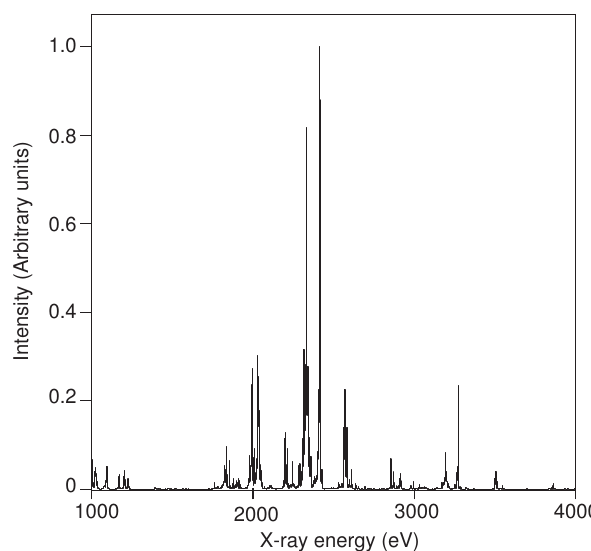
Figure 4. Spectral emission of vanadium-like W 51+ in the 1000 to 4000 eV X-ray range predicted by calculations performed with the Flexible Atomic Code.